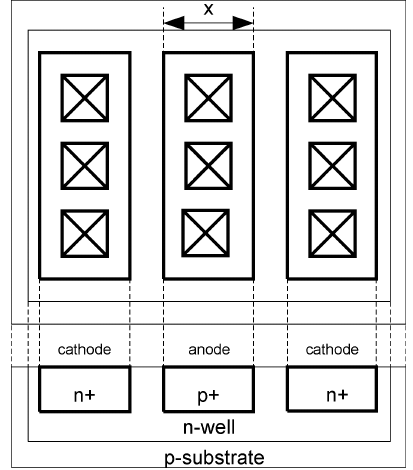
FIGURE 11 p = n junction